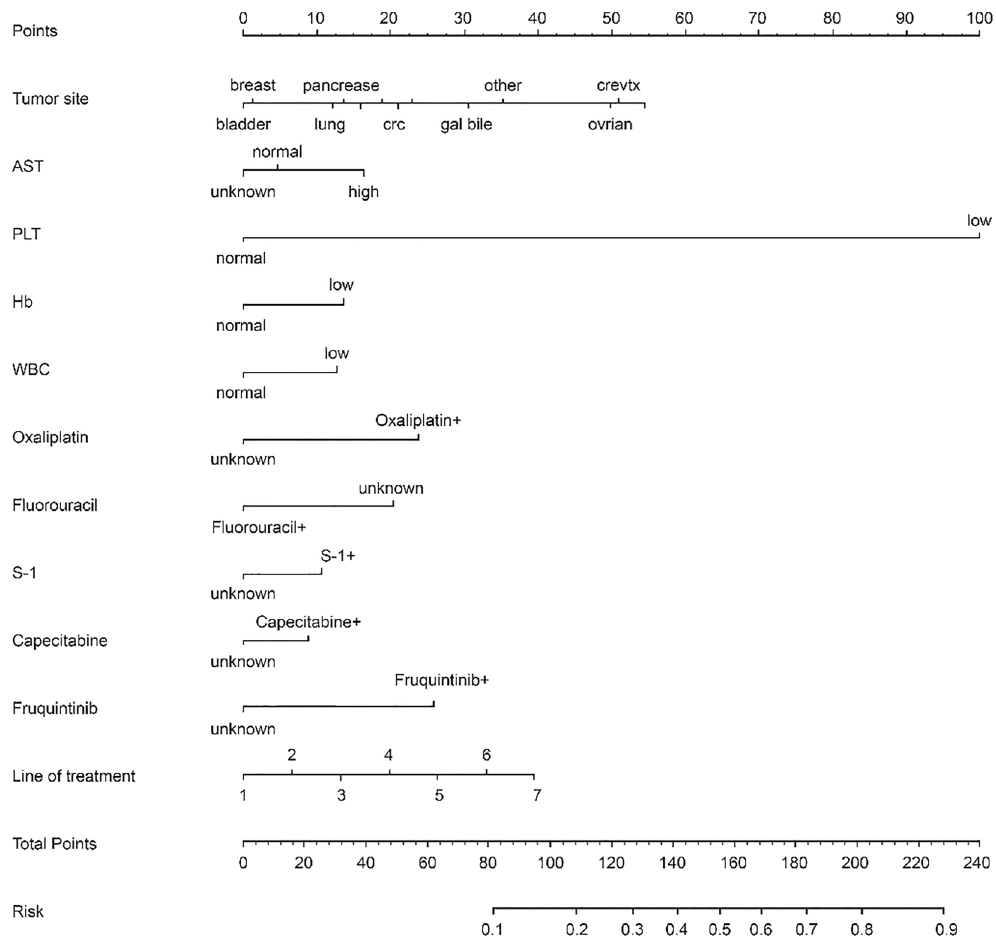
Figure 4. The nomogram model for CIT probability prediction based on chemotherapy cycles.